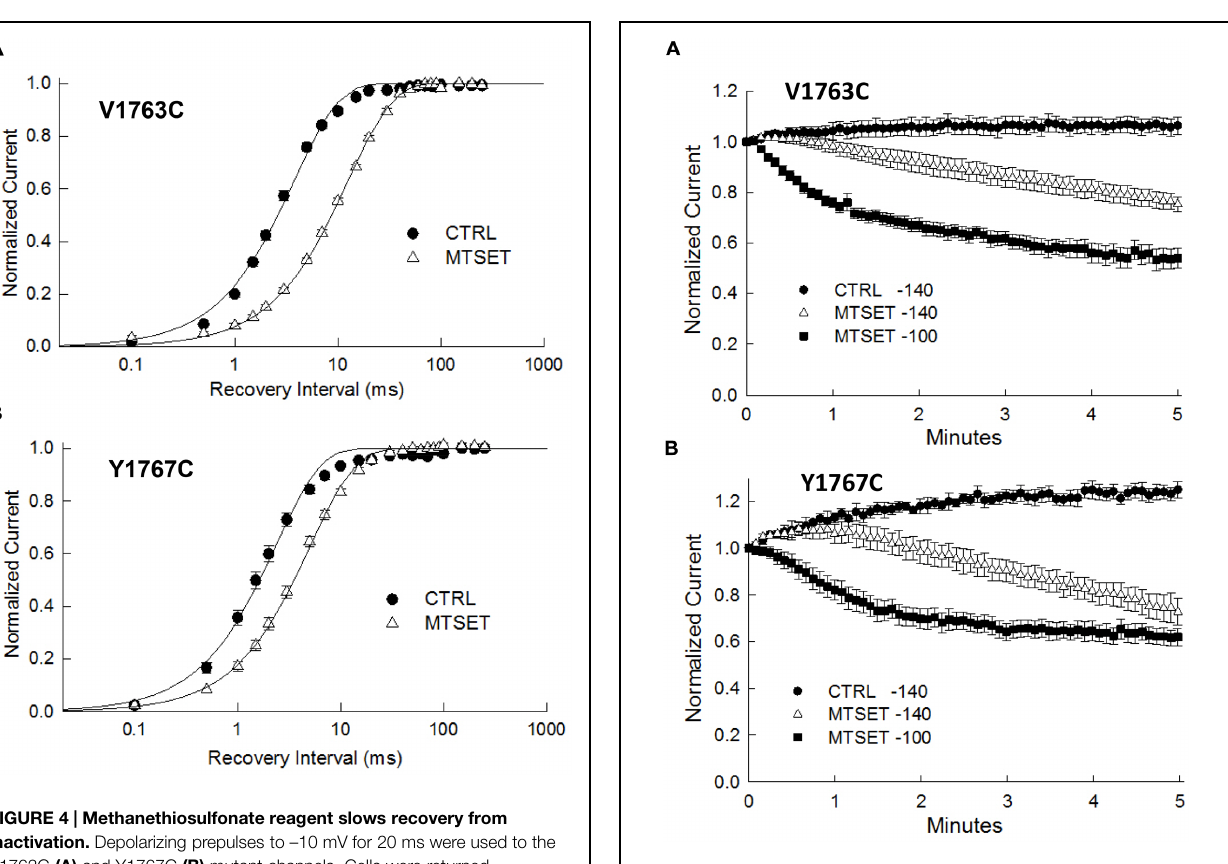
FIGURE 5 | Methanethiosulfonate reagent inhibition is voltage-dependent inhibition. The MTSET inhibition of the V1763C (A) and Y1767C (B) mutants was examined while varying the holding potential between –140 and –100 mV. Standard test pulses to –10 mV for 20 ms were applied at 5 s intervals to assess current amplitude. The test currents were normalized to the current measured immediately after break-in. Plotted are the normalized currents for the V1763C and Y1767C mutants in the absence and presence of 1 mM internal MTSET. Holding at a more depolarized voltage (–100 mV) accelerated the onset of the MTSET inhibition by comparison to the –140 mV holding potential. The data are the means and SEM of the V1763C Control ( n = 9), V1763C MTSET ( n = 4), Y1767C control ( n = 9), and Y1767C MTSET ( n =